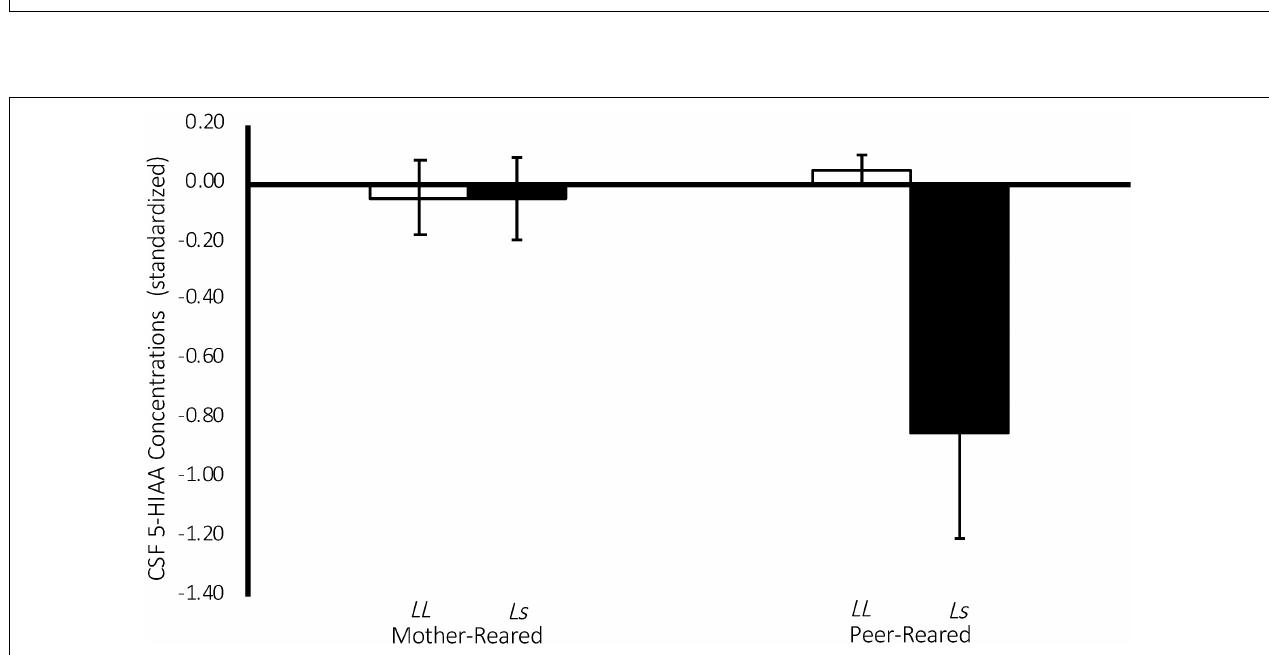
FIGURE 5 | Interaction between 5-HTT genotype and rearing condition on CSF 5-HIAA Concentrations. There was a significant effect of 5-HTT genotype on CSF 5-HIAA concentrations [ F (1,134) = 4.43, p = 0.04], with homozygous subjects exhibiting higher CSF 5-HIAA concentrations on average, when compared to subjects with an s allele. There was also a significant two-way rearing-by-5-HTT-genotype interaction on CSF 5-HIAA concentrations [ F (1,134) = 4.29, p = 0.04], with PR subjects with an s allele exhibiting lower CSF 5-HIAA concentrations on average, when compared to MR subjects with an s allele, or to homozygous MR or PR subjects. MR subjects are represented in white, PR subjects are represented in